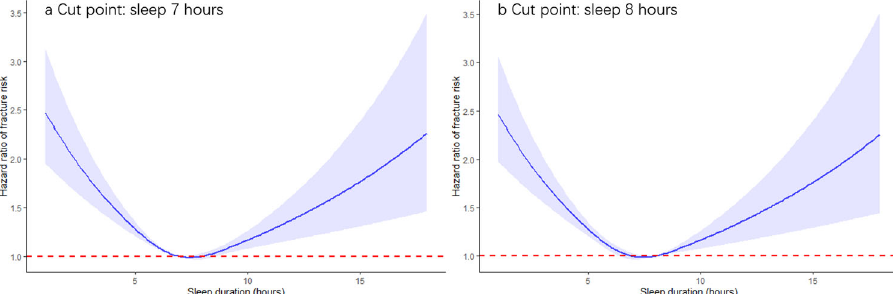
Fig. 2 Observational association of sleep duration with fracture risk using a restricted cubic spline based on model 0 based on different cut points. a Sleeping 7 h per day and b sleeping 8 h per day. Hazard ratios are indicated by blue solid lines and the 95% con fi dence intervals by blue shaded areas. The red line denotes the harzard ratio of one. In all these analyses, models were adjusted for risk factors for fracture, including age, sex, body mass index, education, smoking, alcohol consumption, physical activity, cognitive impairment, depression, and the use of glucocorticoid medication, benzodiazepines, and